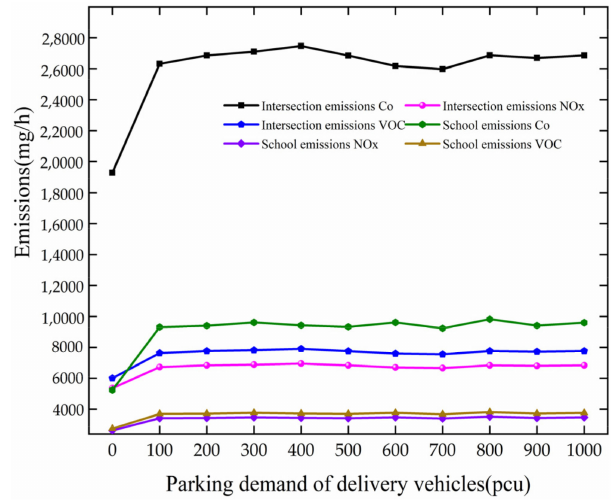
Figure 18. Variation trend of pollutant gas emission with